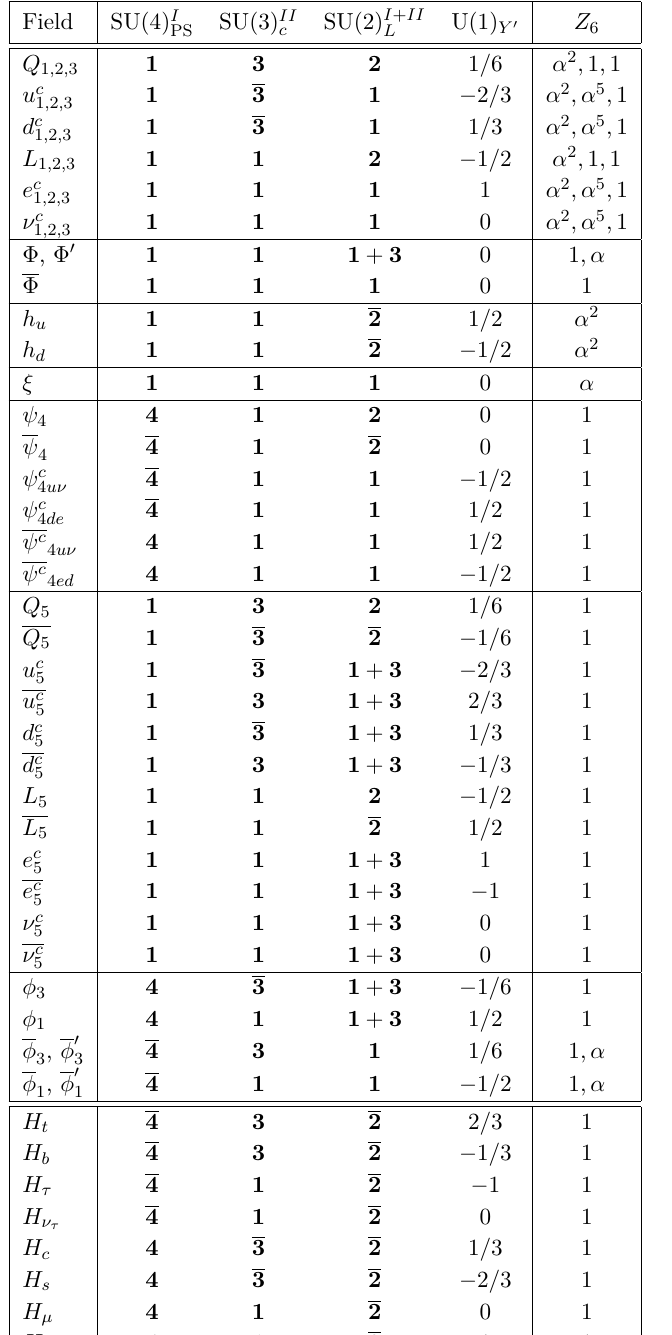
Table 3 . Under the subgroup G 4321 , the fields of tables 1, 2 decompose as shown. We have dropped the Higgs H 0 , H 0 , and the φ (1 / 2 , − 1 / 2 , − 3 / 2) , and Φ states with Y 0 = (1 , 0 , − 1) , coming from the SU(2)